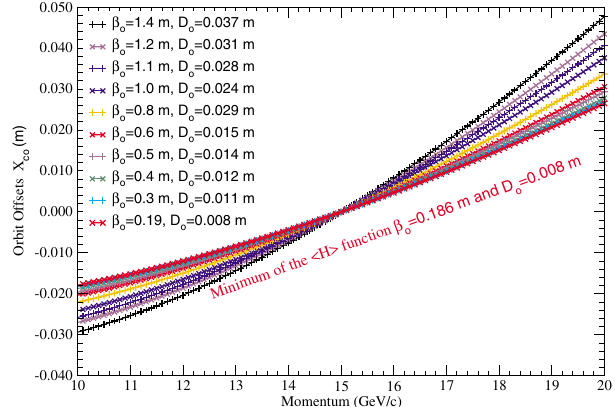
FIG. 8. (Color) Dependence on momentum of maximum orbit offsets. The smallest orbit offsets correspond to the minimum of the h H i function. Corresponding initial conditions for the am- are shown. plitude function (cid:5) x